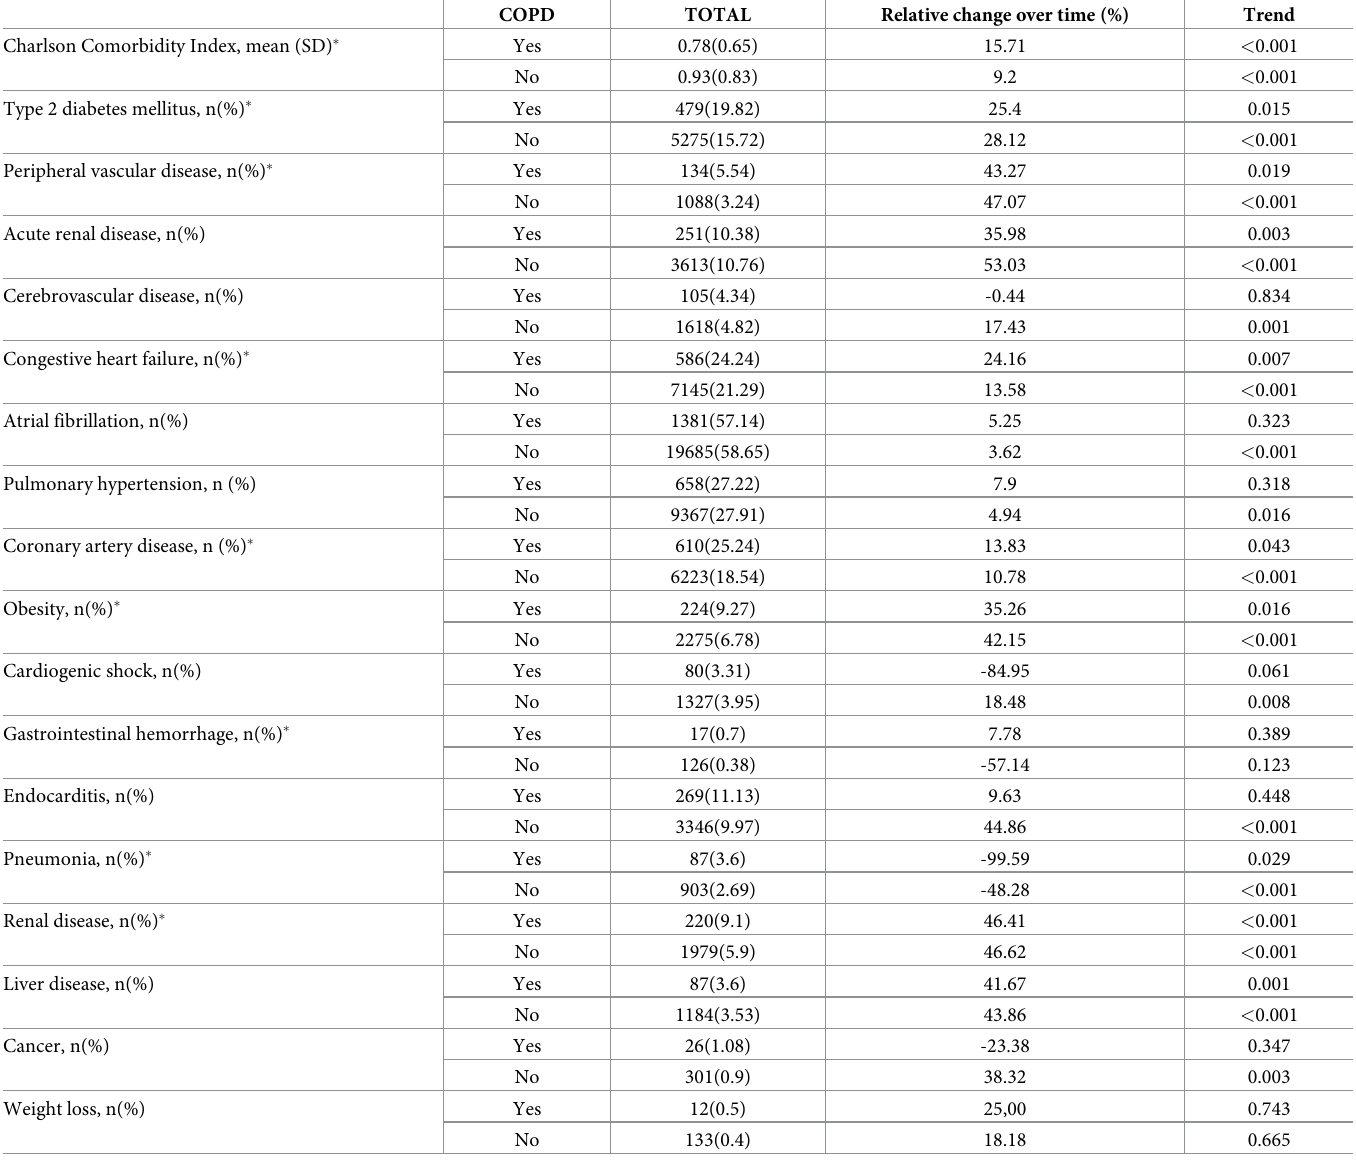
Table 3. Comorbidity of patients hospitalized that underwent a mechanical mitral valve replacement in Spain from 2001 to 2015 according to COPD status. COPD TOTAL Relative change over time (%) Trend Charlson Comorbidity Index, mean (SD)